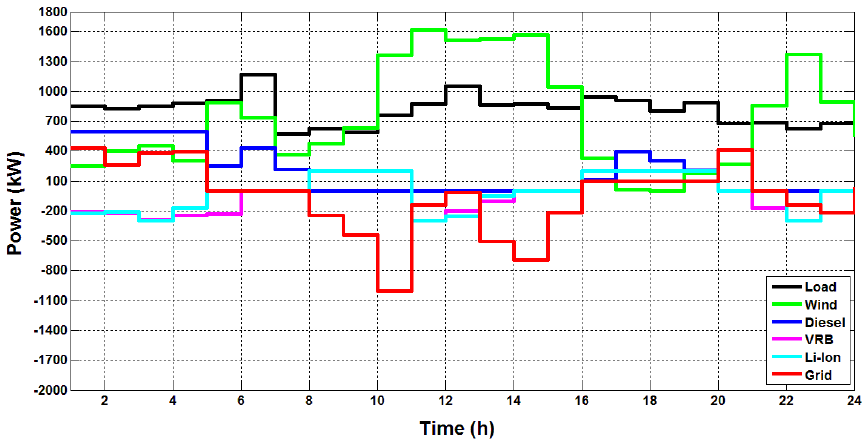
Figure 9. Pattern search PS-based EMS solution.